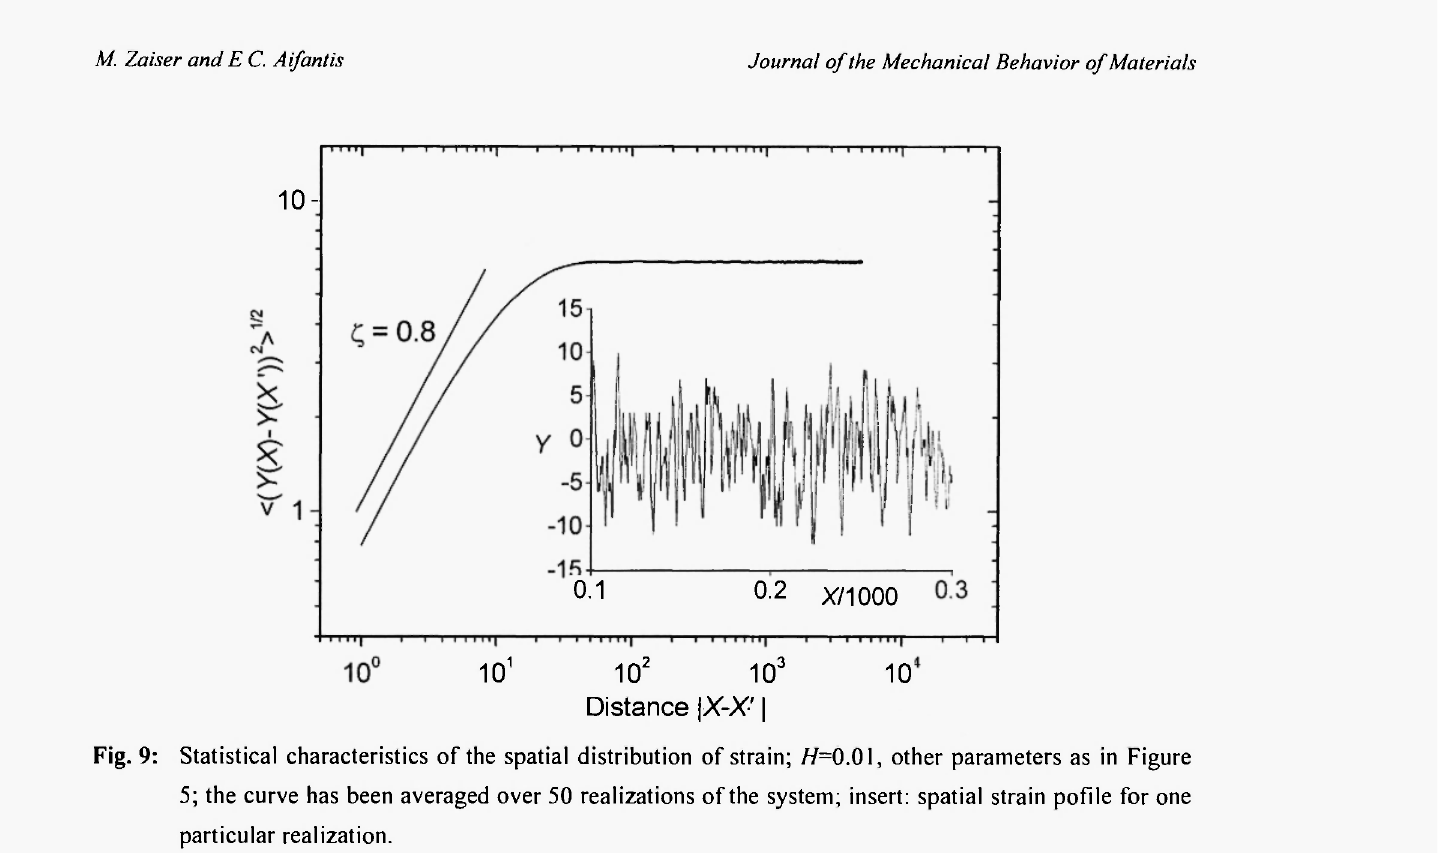
Fig. 9: Statistical characteristics of the spatial distribution of strain; H= 0.01, other parameters as in Figure 5; the curve has been averaged over 50 realizations of the system; insert: spatial strain pofile for one particular